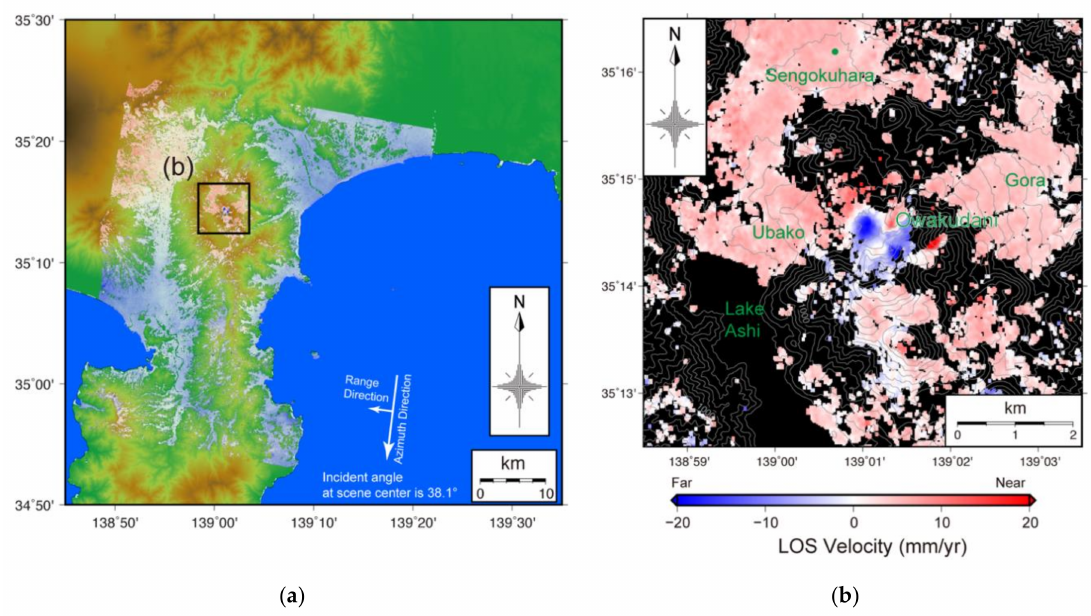
Figure 6. Distribution of LOS velocity in the descending orbit for the ( a ) entire region; ( b ) area of interest shown in the black rectangle (inset) in ( a ). The base map of ( a ) is a topographical map based on 10 m mesh height data released by the GSI, and its color scale is the same as Figure 1. Intervals of contour lines in ( b ) are 50 m in